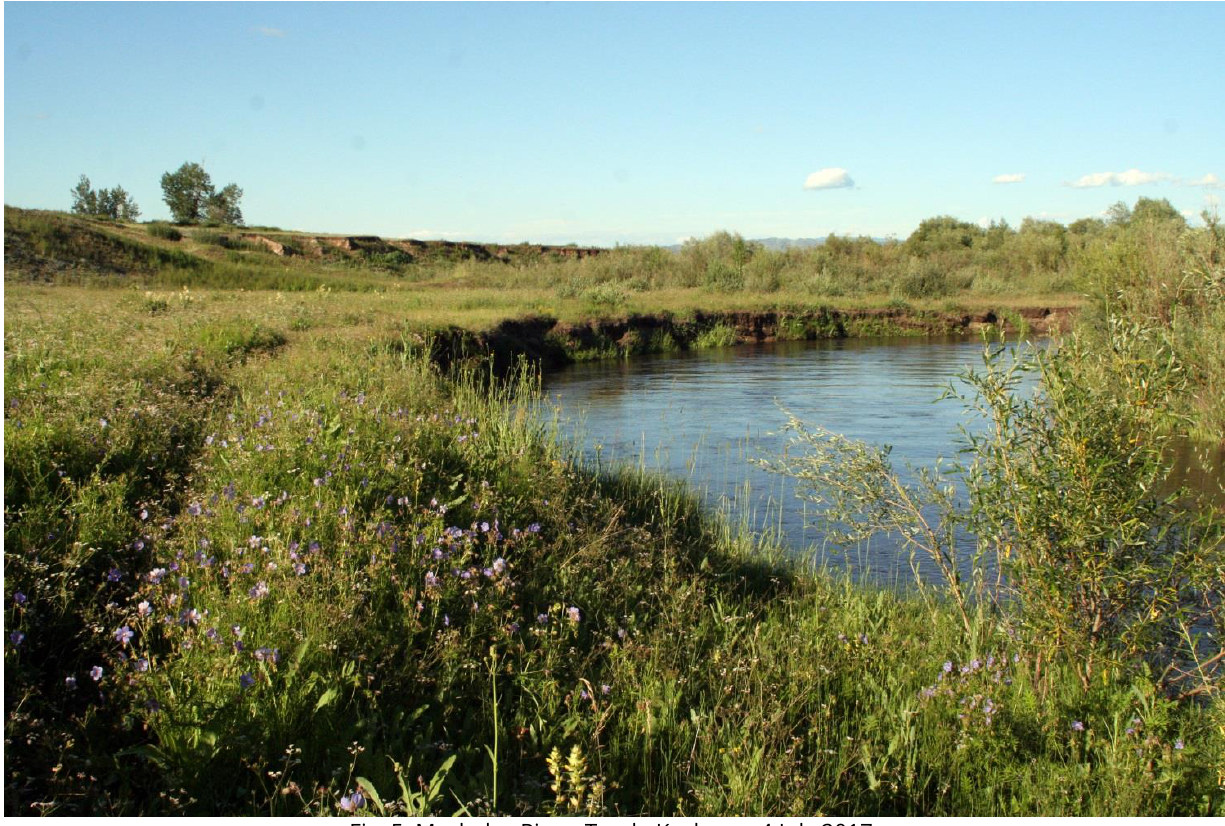
Fig. 5. Mazhalyg River. Tanda Kozhuun, 4 July 2017.